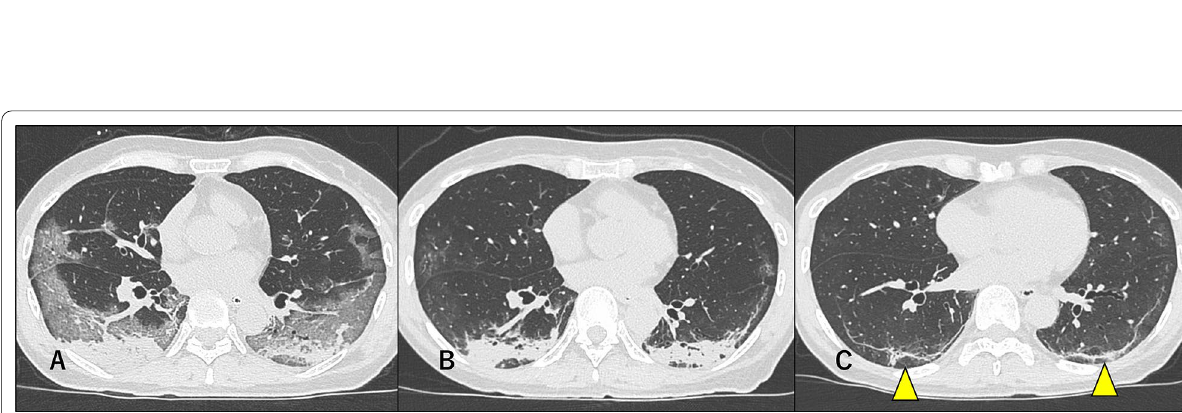
Fig. 3 Severe COVID-19 pneumonia in a 62-year-old woman. a At intubation (8 days after symptoms onset): Bilateral, subpleural, and non-segmental GGOs and posterior consolidation were observed. b At discharge (18 days after symptoms onset): Bilateral and posterior subpleural lines appeared. c At 1-month follow-up (47 days after symptoms onset): The subpleural lines were still present (arrowheads)